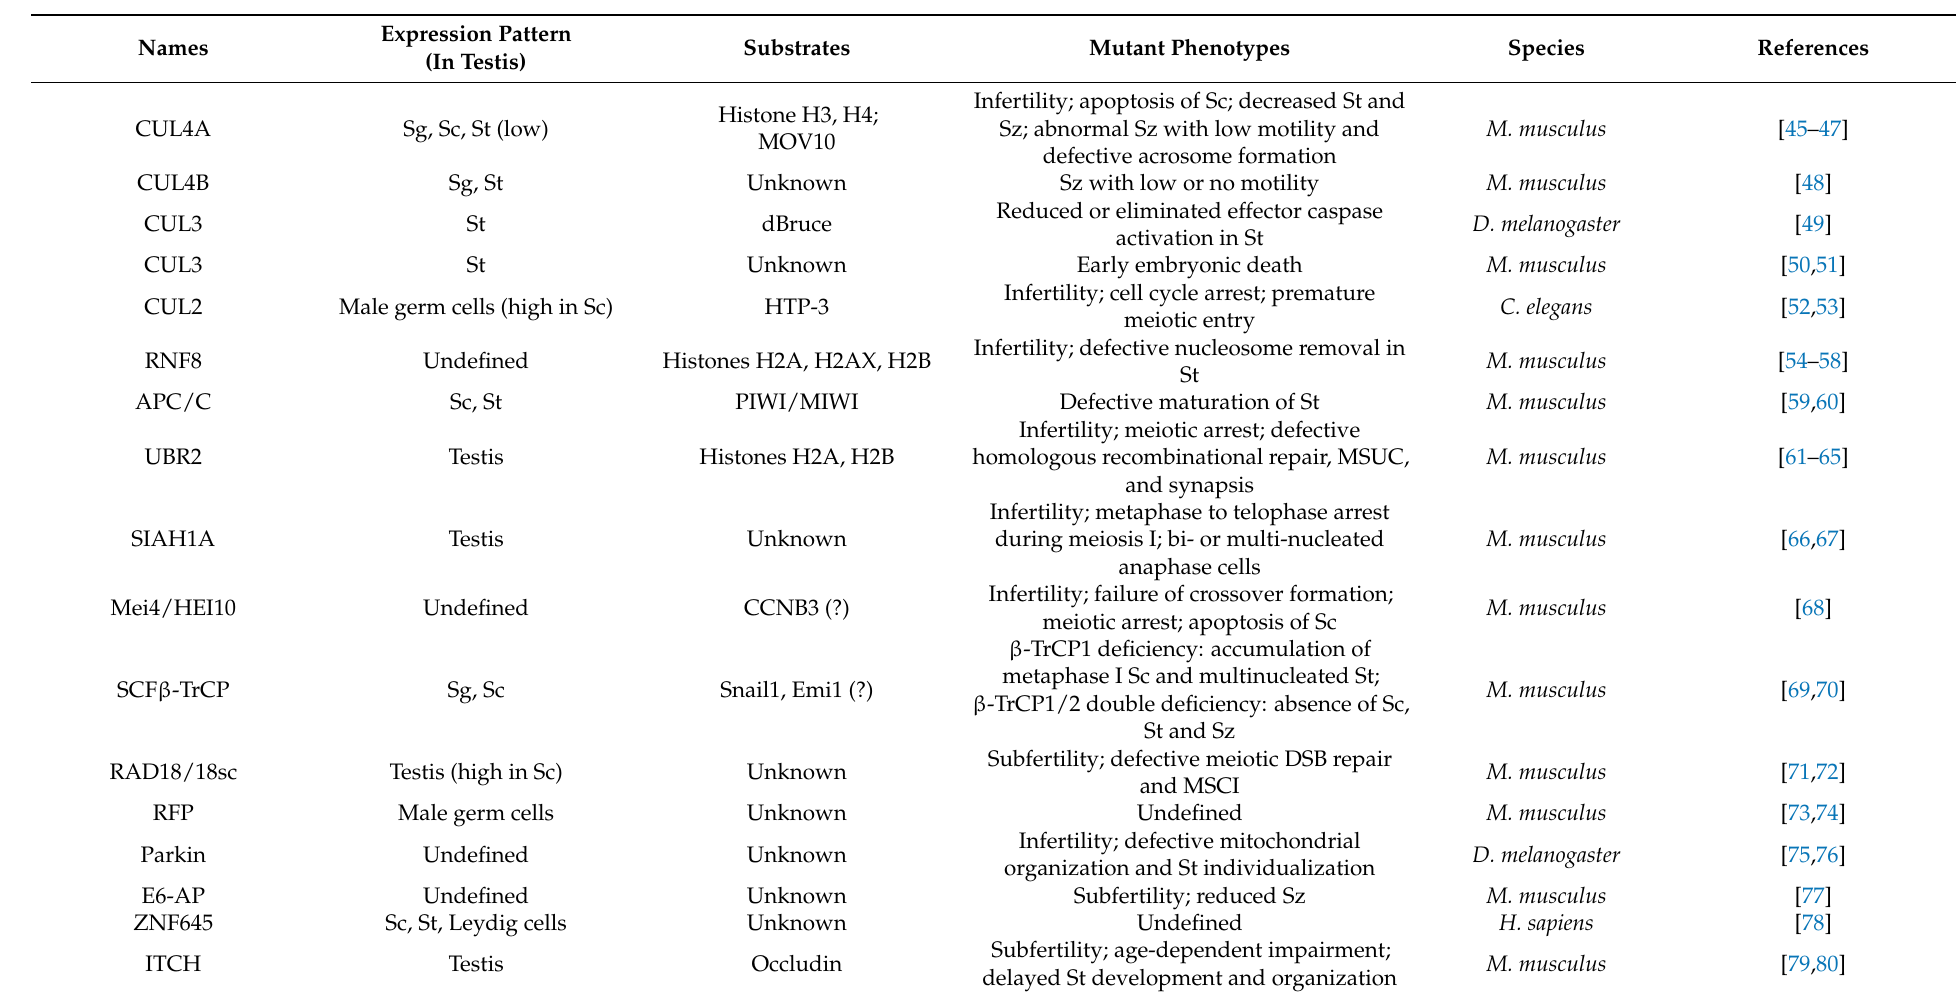
Table 1. Overview of E3 ubiquitin ligases associated with